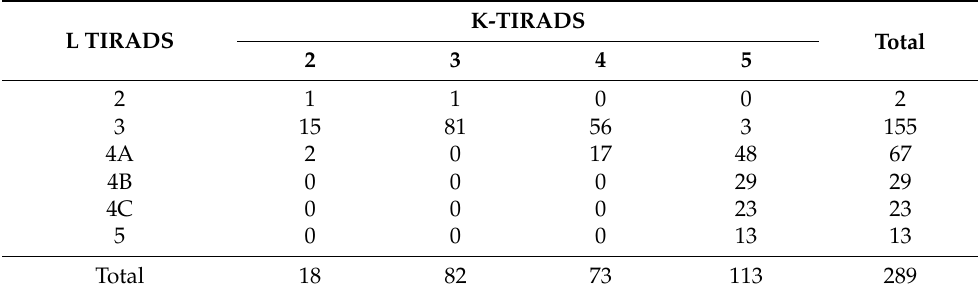
Table 9. Comparison between the L -TIRADS and K-TIRADS classifications. L TIRADS